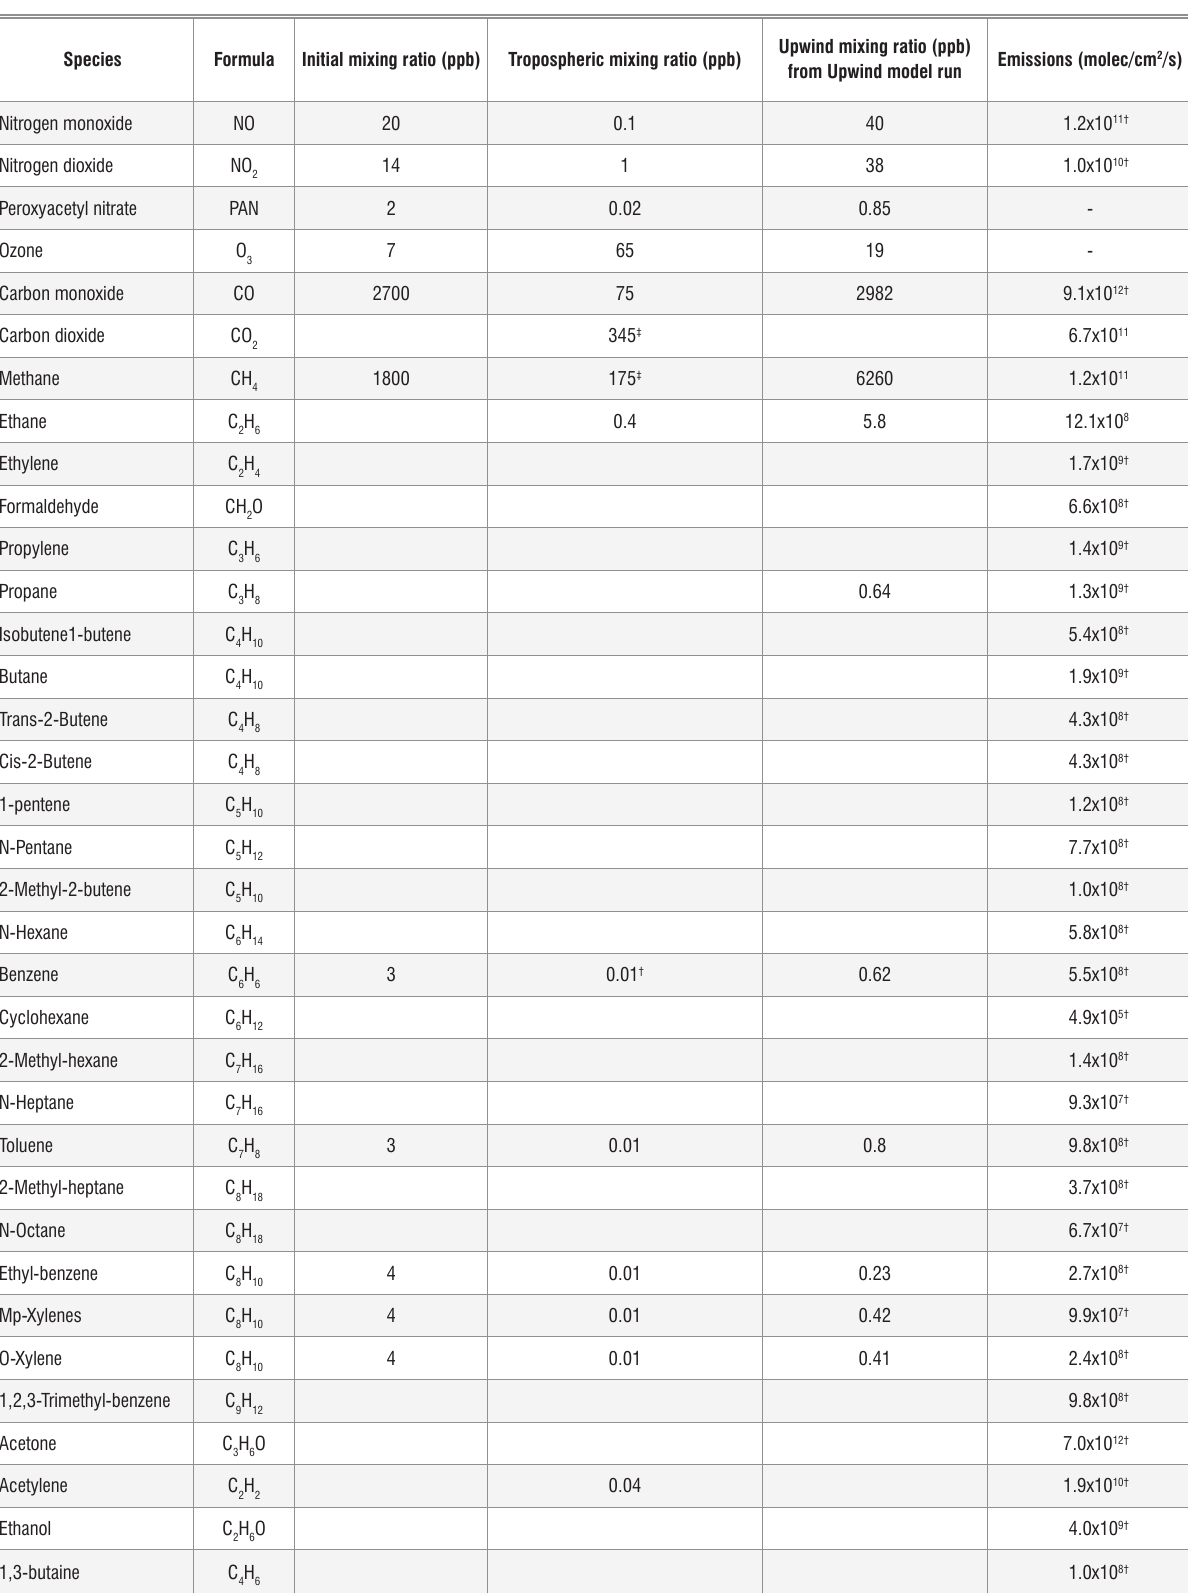
Table 4: Vehicle emissions for Johannesburg-Pretoria megacity according to the Euro classification 29